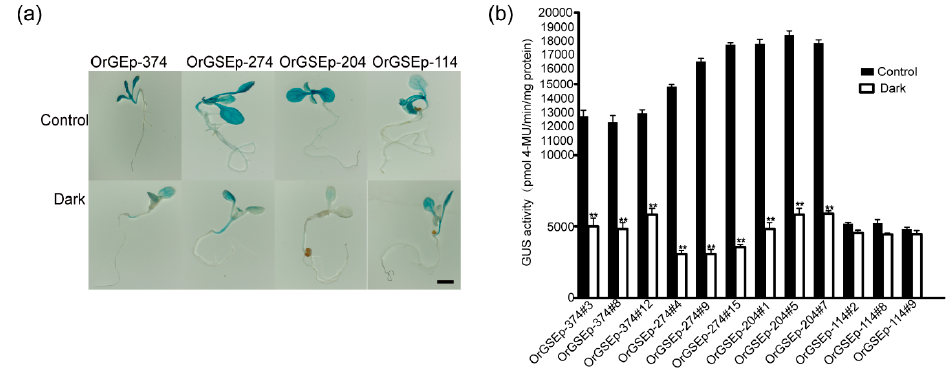
Figure 6. GUS staining and quantification of GUS activity of transgenic Arabidopsis seedlings containing different 5’-promoter deletion fragments grown under light and dark conditions. ( a ) Ten-day-old seedlings were stained to observe GUS expression. Bar = 1 cm; ( b ) Quantification of GUS activity in 20-day-old T3 transgenic Arabidopsis grown under light and dark conditions. OrGSEp-374#3, OrGSEp-374#8 and OrGSEp-374#12 are three positive transgenic lines carrying the OrGSEp-374